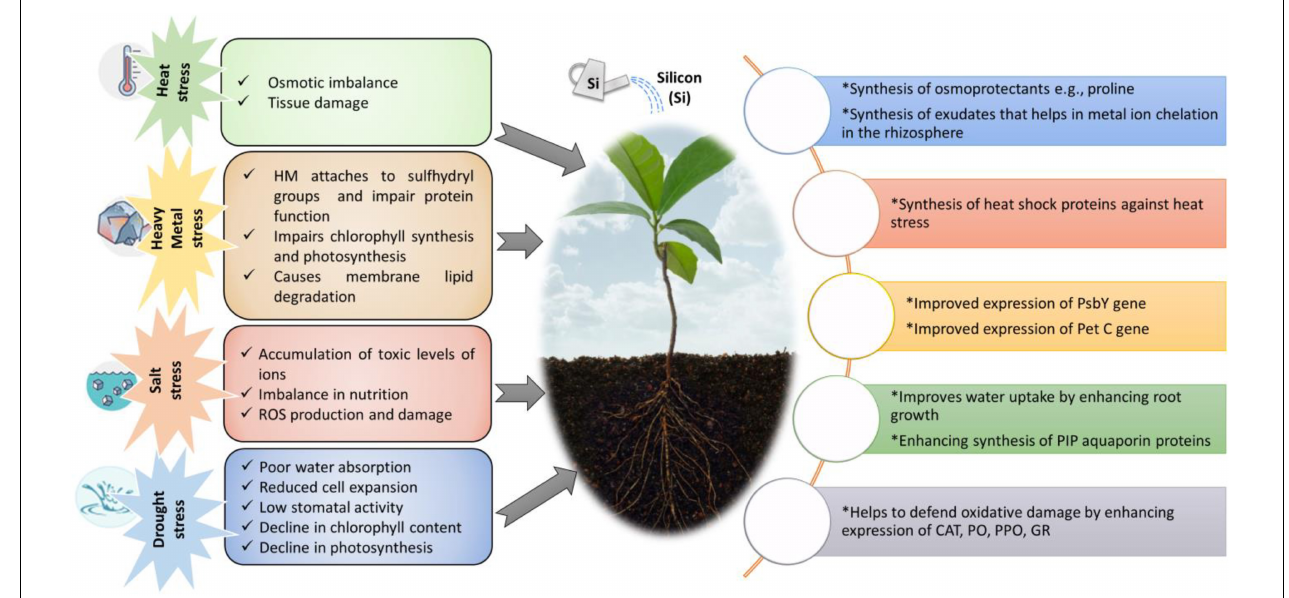
FIGURE 1 | Impact of abiotic stress on various aspects of plant growth and defense mechanisms evoked by application of Si.